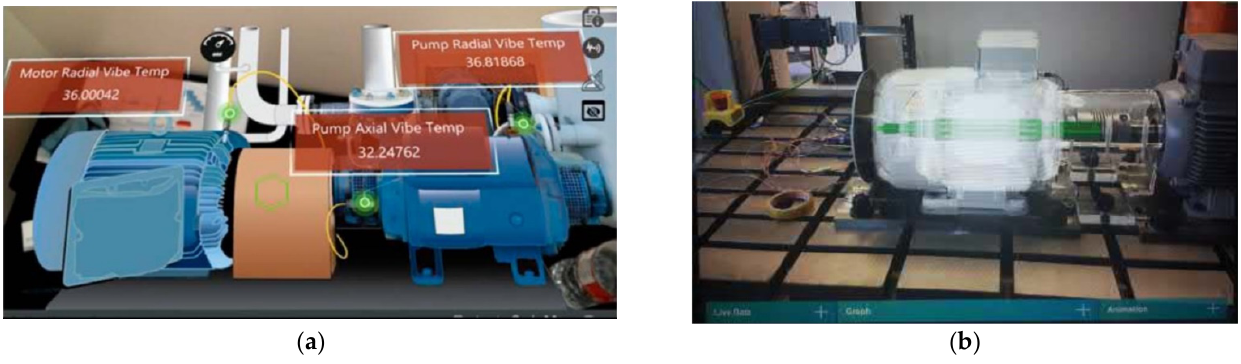
Figure 5. ( a ) Augmentations displayed to the operator during inspection of an asset [47]; ( b ) Healthy shaft (in green) of an electric motor [68].